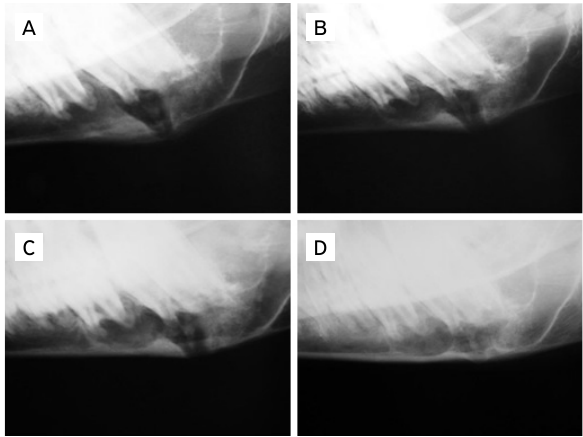
Figure 4. Radiographs of treatment evolution of the horizontal branch of the right mandible of animal of the ovine specie, identification number 389, adult, female, mixed Dorper with Santa Inês, with diagnosis of Actinomycosis. (A) It was observed in rostral region of the root of the third molar tooth lysis that extended leading to cortical discontinuity. Involving the lesion was an area of sclerosis and a smooth periosteal reaction; (B) it was observed extension of the lesion to the root of the second molar tooth; (C) there was an increase in intralesional radiopacity and surrounding sclerosis; (D) the lesion was almost imperceptible with radiopacity, equating to adjacent normal bone tissue with a discrete halo of surrounding